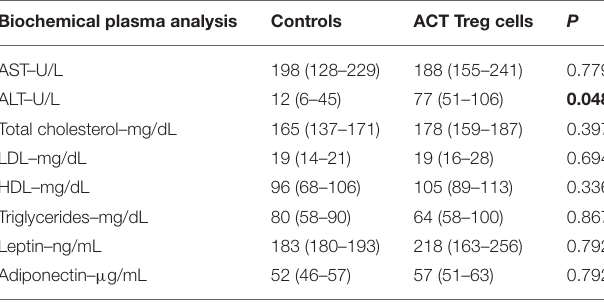
TABLE 2 | The effect of adoptive Treg cell transfer on biochemical plasma parameters. Biochemical plasma